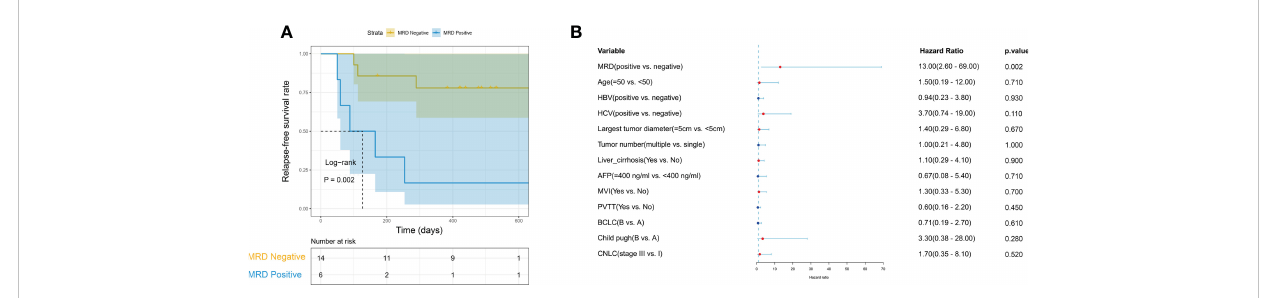
FIGURE 4 The predictive value of MRD status for early relapse. (A) Kaplan-Meier curves comparing RFS between MRD-positive and -negative patients with HCC. (B) The univariate Cox regression analyses reveal that only MRD status is signi fi cantly associated with RFS. HCC, hepatocellular carcinoma; MRD, minimal residual disease; RFS, relapse-free survival.